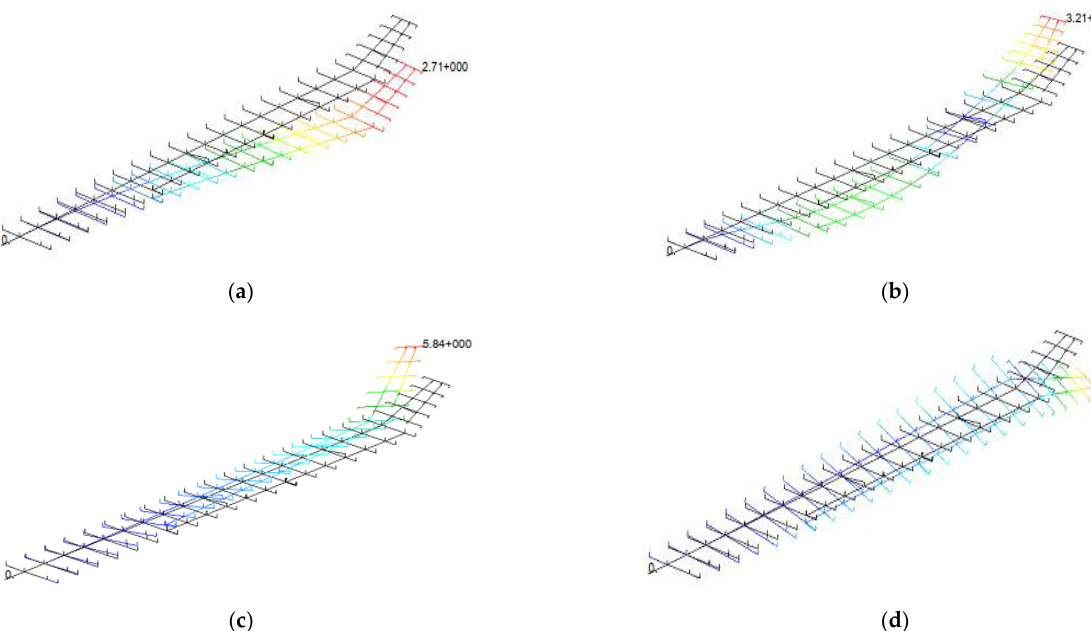
Figure 5. Wing component modal shape of first four elastic modes. ( a ) 1st vertical bending. ( b ) 2nd vertical bending. ( c ) 1st horizontal bending. ( d ) 1st torsion.